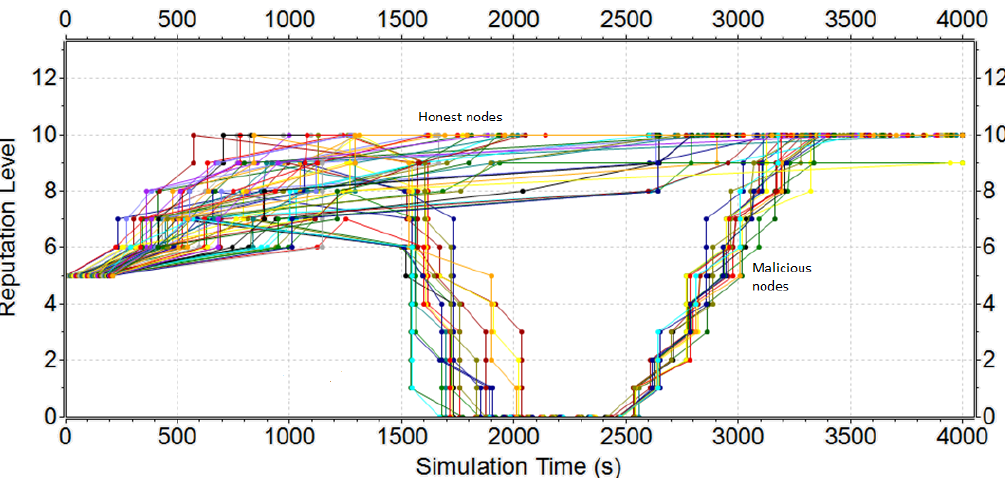
Figure 13. Reputation evolution—Betrayal attack—Manhattan-Grid Scenario.